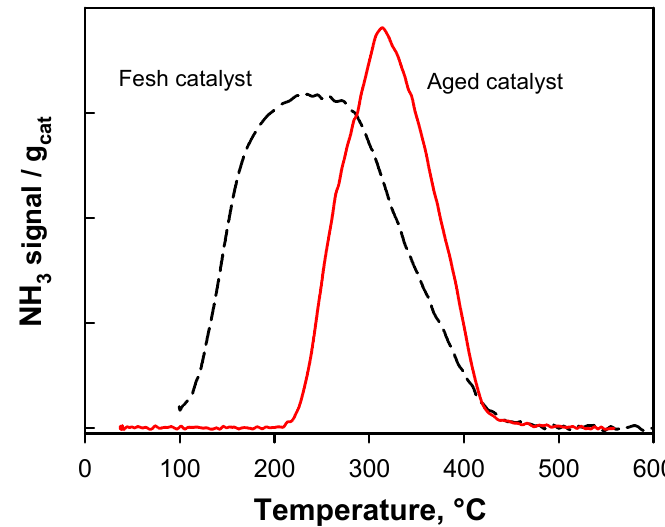
Figure 4. NH 3 temperature programmed desorption (TPD) of fresh and aged catalyst.